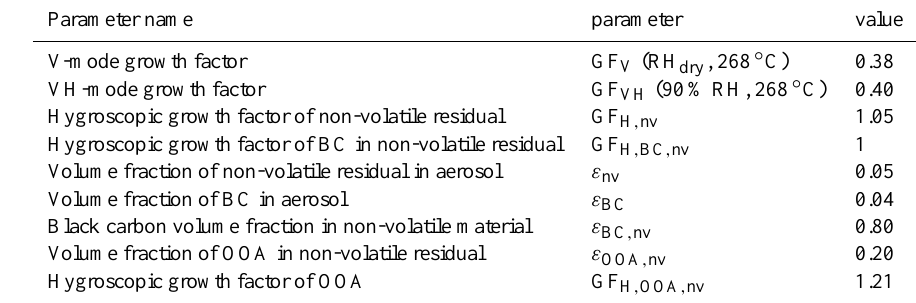
Table 2. Parameters used in the estimation of hygroscopicity (hygroscopic growth factor) of very-low-volatile organics denoted here as OOA (oxidized organic aerosol) based on VH-TDMA data (particle diameter 110nm, relative humidity 90% and temperature 268 ◦ C) (see Eq.